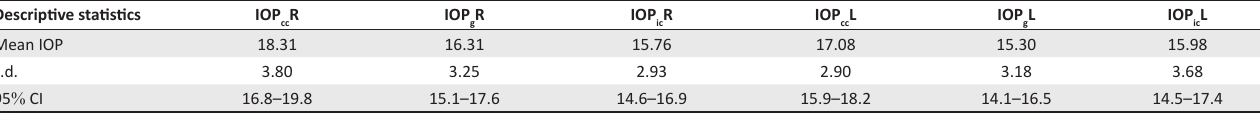
TABLE 1: Descriptive statistics for the data collected from 28 subjects. Descriptive statistics